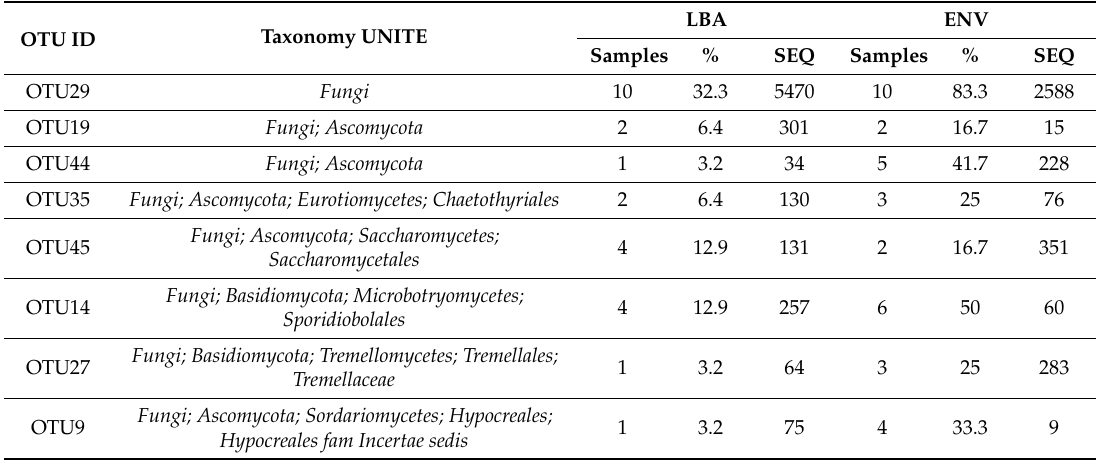
Table 4. OTUs that did not produce hits identified at a genus level by 97% similarity in the UNITE database.